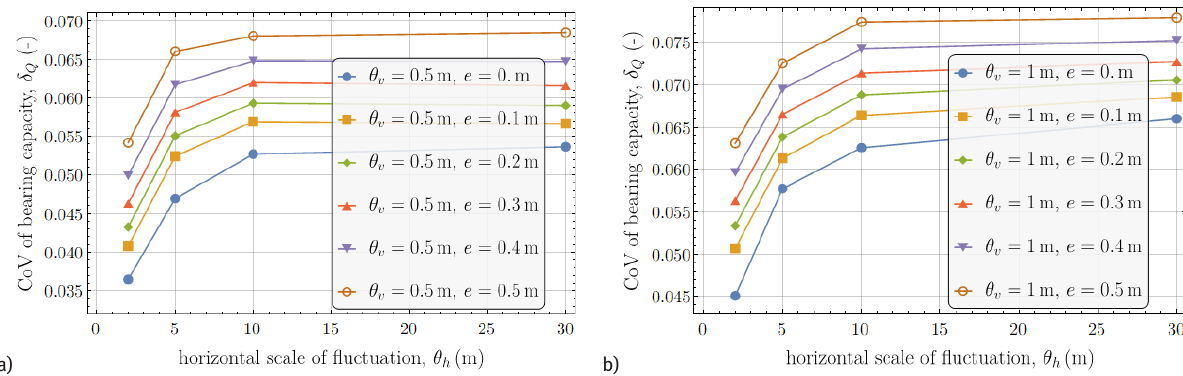
on CoV δ for a) θ = 0.5 m and b) θ h Q v